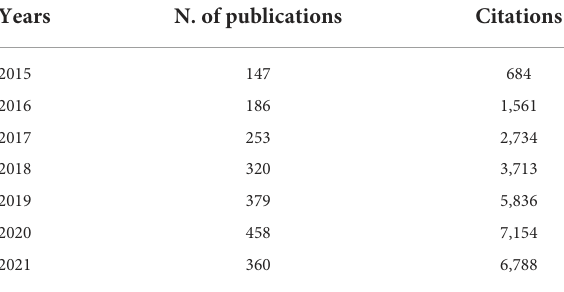
TABLE 2 Publications and citations from 2015 to October, 2021. TABLE 3 Main areas of